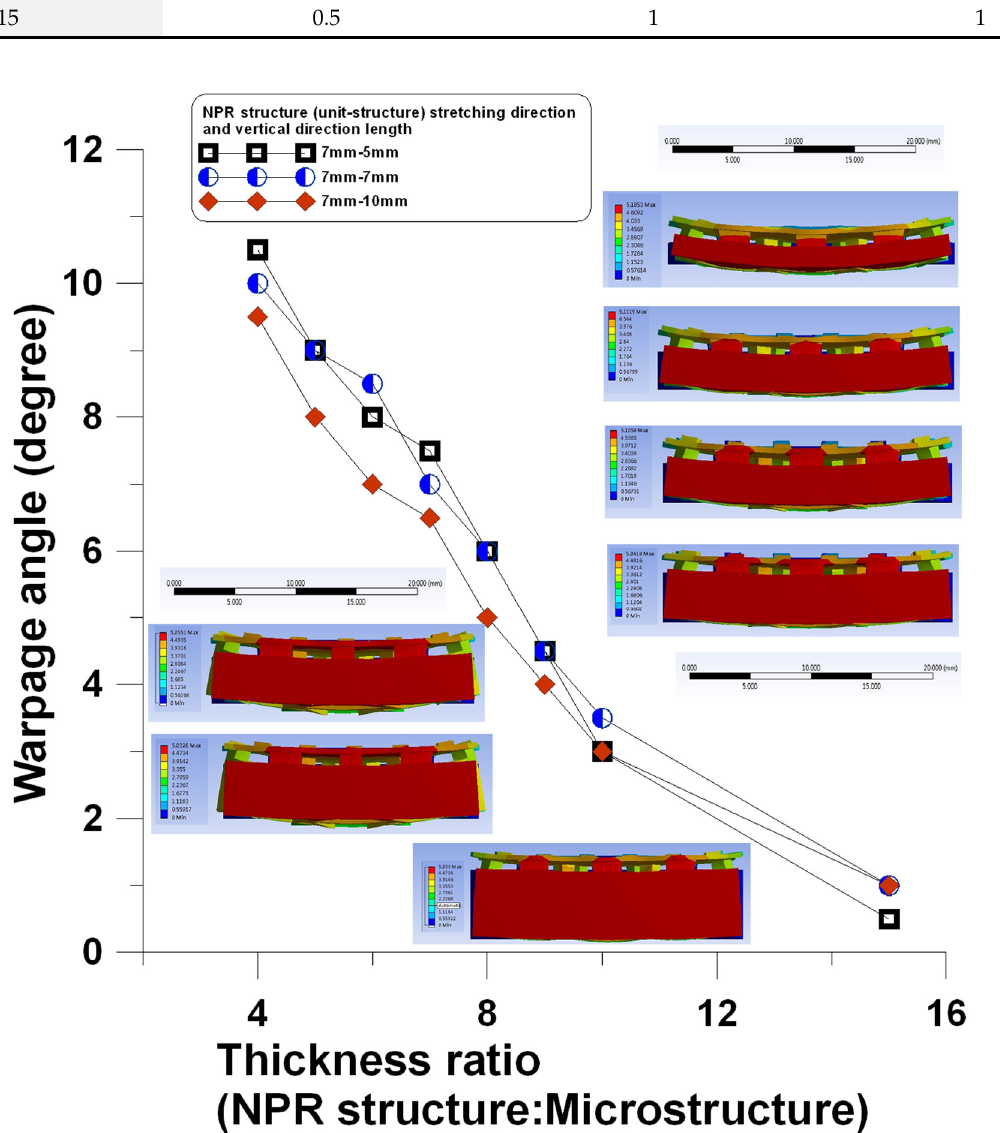
Figure 17. Effects of different NPR structure mold dimensions on the warping angle perpendicular to the stretching direction at a fixed stretching length.